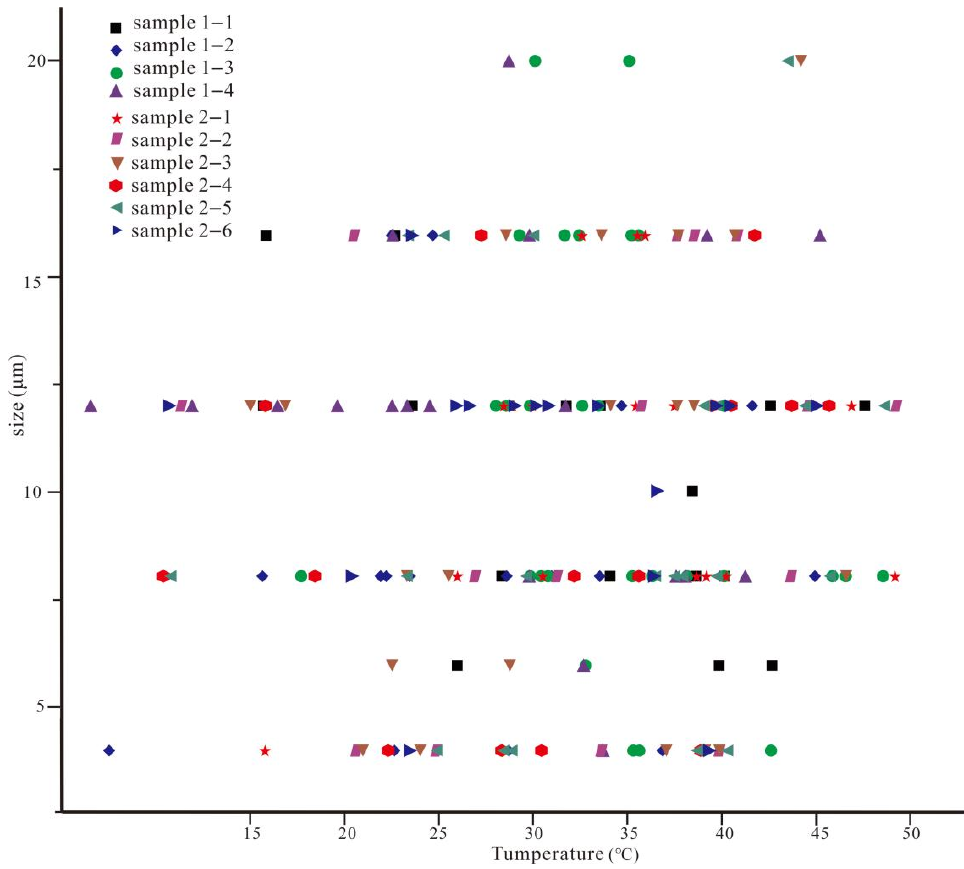
Figure 6. Relationship between homogeneous temperature and inclusion size of fluid inclusion in halite of well S1.